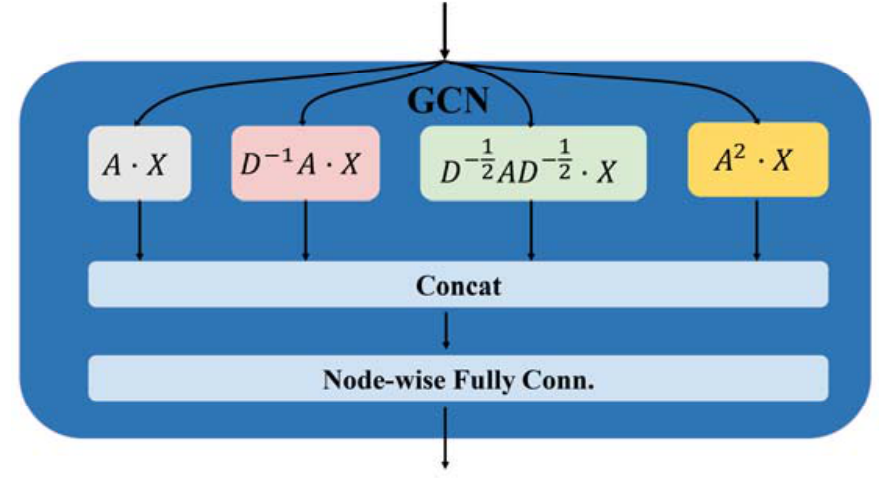
Figure 3. Design of the graph convolution block for HLGNN-MDA.